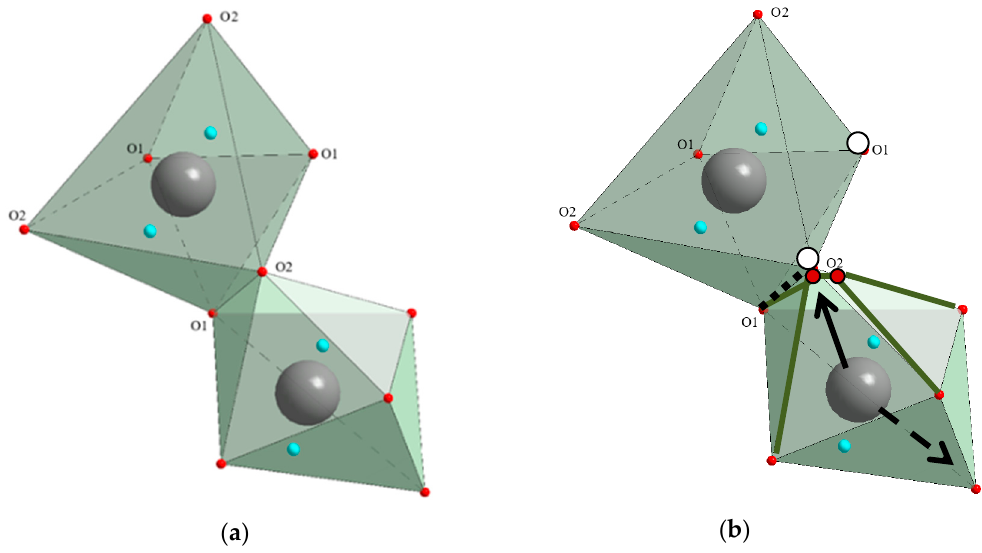
Figure 10. Model of rearrangement of ( a ) the BiO 6 and DyO 6 octahedra into ( b ) the vacancy BiO 5 octahedron and DyO 7 octahedron with a split top. The solid arrow shows the direction of Dy 3 + displacement with the formation of the DyO 7 polyhedron. The dashed arrow shows the direction of Dy 3 + displacement o with the formation of the DyO 5 polyhedron.